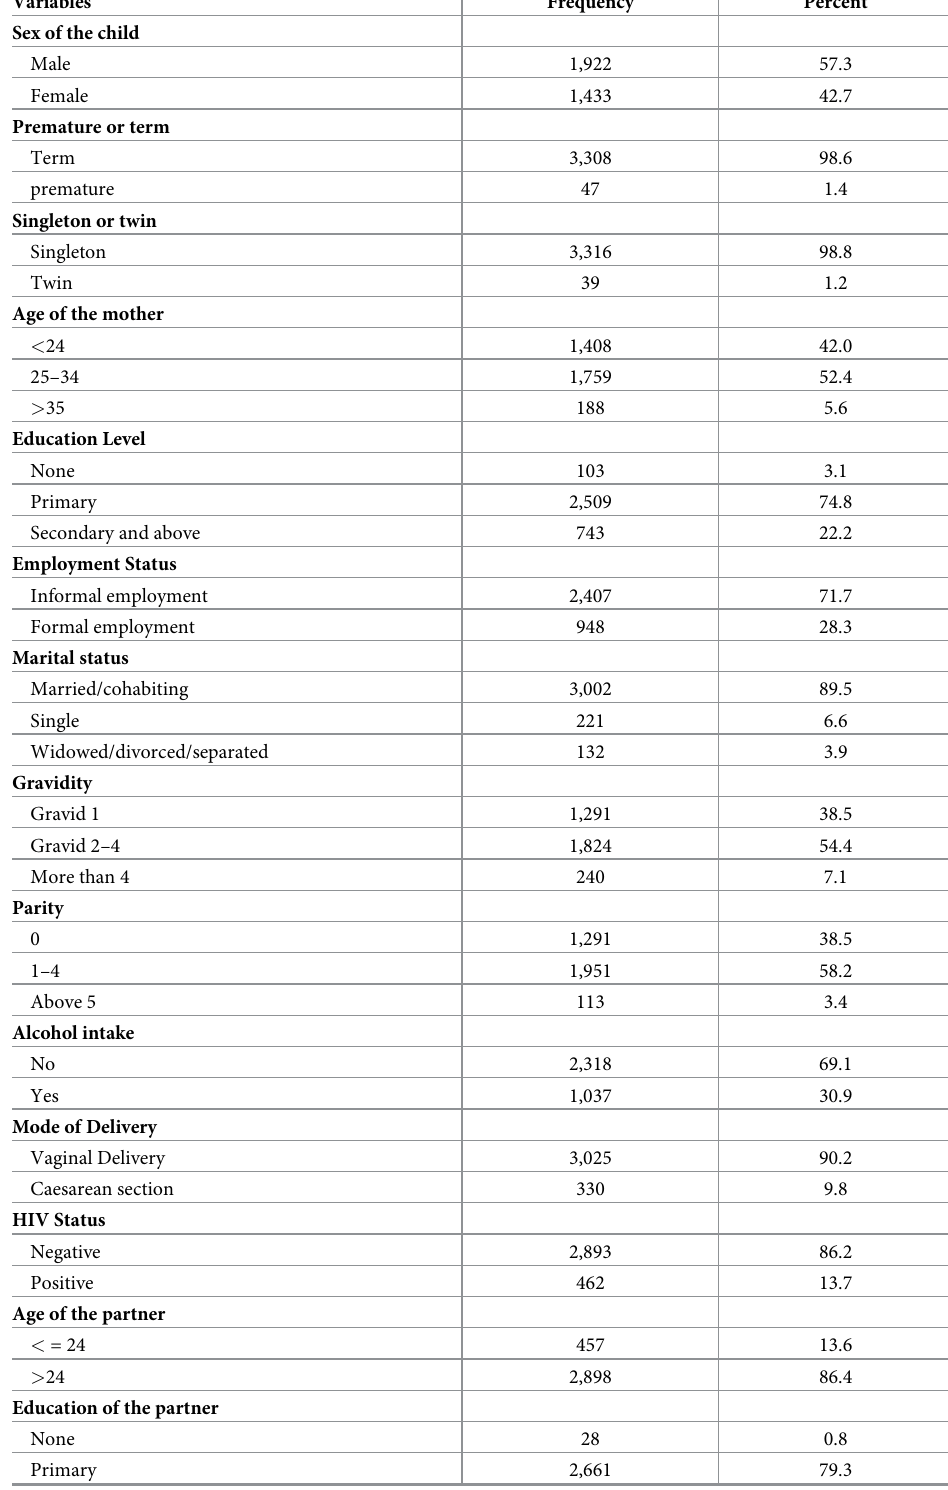
Table 1. Child and maternal baseline characteristics (N =